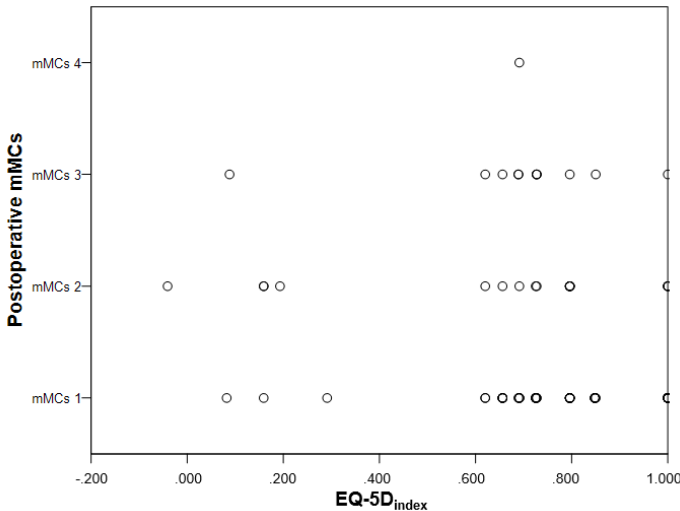
Figure 3. Scatterplot showing lack of correlation between the postoperative mMCs grade and EQ-5D index. 3.5. Employment status and return to work after spinal meningioma surgery.